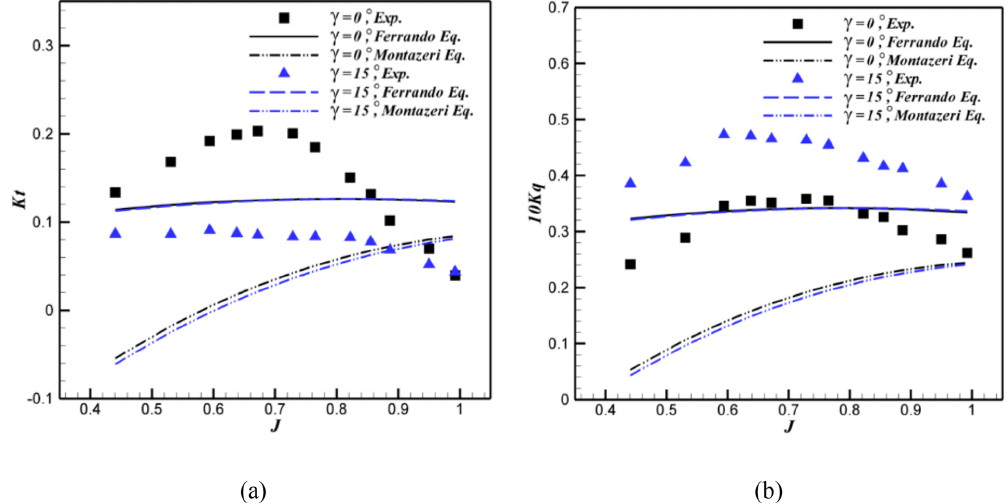
Figure 11. Comparison of the surface-piercing hydrodynamic coefficients predicted using Ferrando et al. (2007) and Montazeri and Ghas- semi (2009) semi-experimental coefficients with the experimental